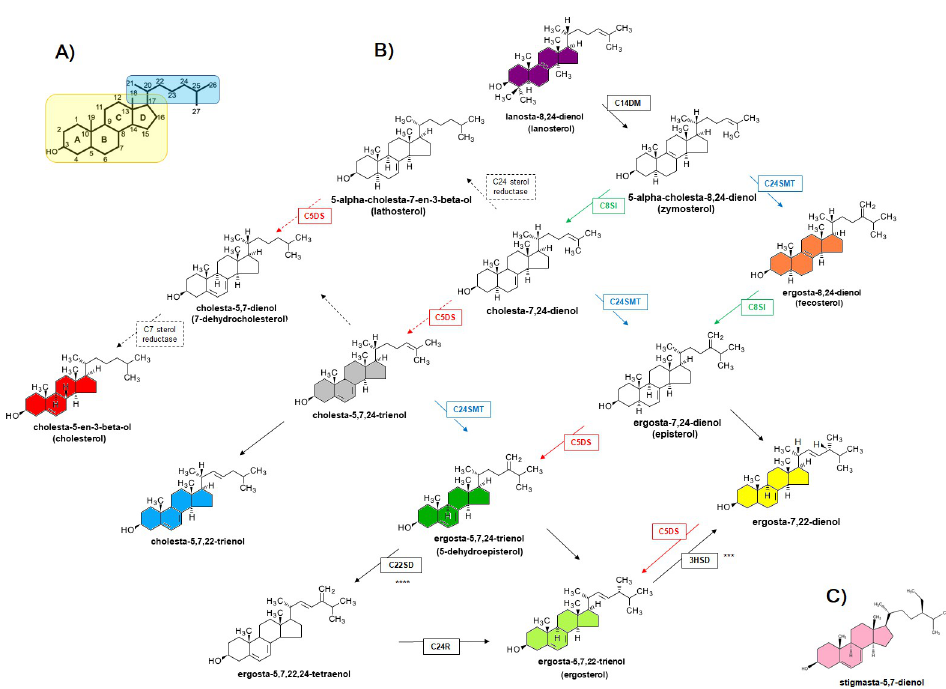
Fig 3. Sterol Biosynthesis in Leishmania spp . Fig 3A) Numbering system of the carbons in the sterol ring (boxed in yellow) and side chain (boxed in blue). Fig 3B) Molecules shadowed (colours) indicate sterols found in this work. Enzymatic steps known in mammals (dotted arrows & boxes) and in Leishmania spp . (solid arrows & boxes) are sterol C14 demethylase, LmxM . 11 . 1100 (C14DM); sterol C24-methyltransferase, LmxM . 36 . 2380 and LmxM . 36 . 2390 (C24SMT) (blue); C8-sterol isomerase, LmxM . 08_29 . 2140 (C8SI) (green); sterol C5 desaturase or lathosterol oxidase, LmxM . 23 . 1300 (C5DS) (red); sterol C22 desaturase or cytochrome p450-like protein, LmxM . 29 . 3550